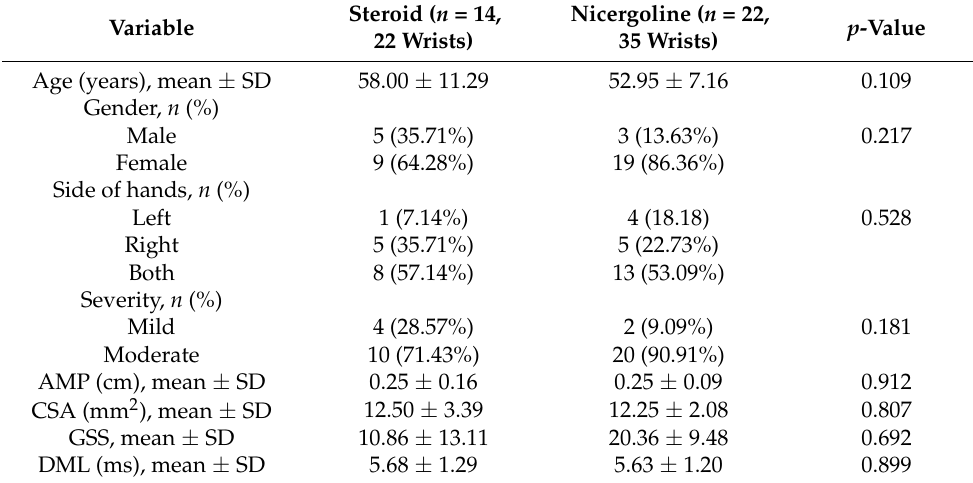
Table 1. Baseline